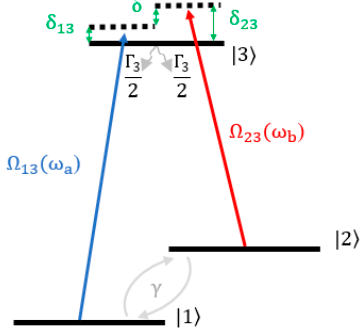
Figure 1. Scheme of three-level Λ system for CPT interrogating.